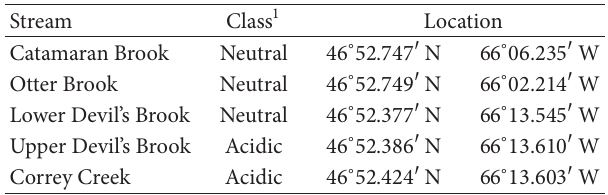
Table 1: GPS coordinates of study sites in five Atlantic salmon ( Salmo salar ) nursery streams in Northumberland County, NB,